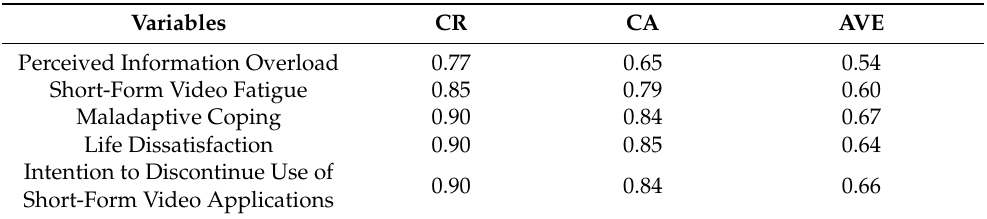
Table 1. CR, CA, and AVE